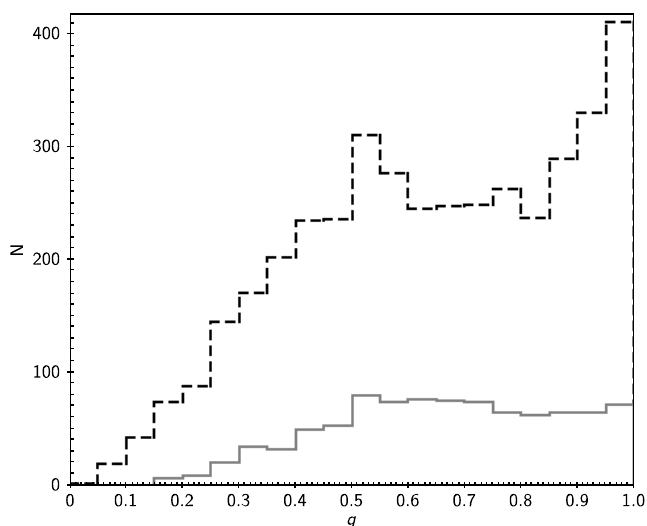
Fig. 4. Distribution over the mass ratio q obtained for the binaries with main com- ponents of luminosity class V and known trigonometric parallaxes. The dashed line represents the complete available sample of 4049 binary stars and the solid line, the re- stricted sample of 892 binaries. The restricted dataset avoids regions of observational incompleteness in the ( V 1 , V 2 , ∆ V, ρ ) space of